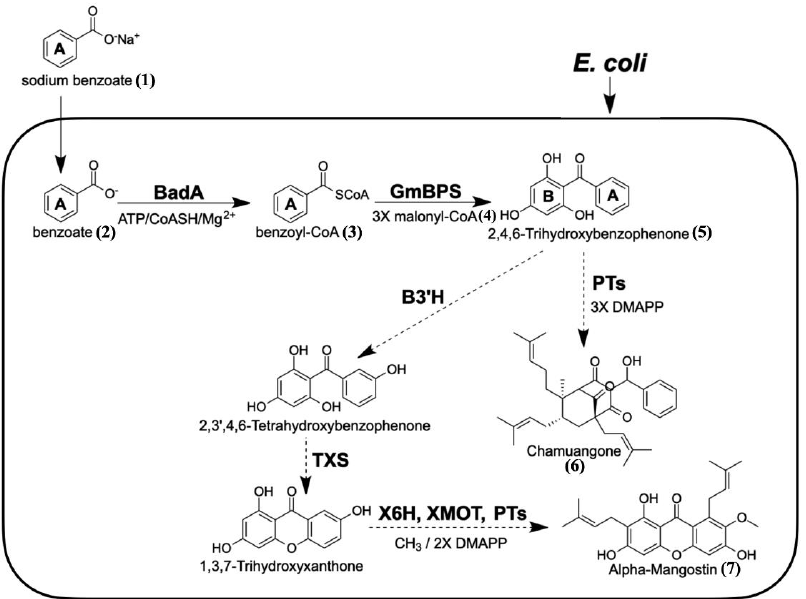
Figure 1. Proposed biosynthetic pathway of 2,4,6-TriHB ( 5 ) in E. coli via the coexpression of BadA and GmBPS (heavy lines). Sodium benzoate ( 1 ) was used as the fed precursor. The synthetic routes that might be extended from 2,4,6-TriHB ( 5 ) towards alpha-mangostin ( 7 ) and chamuangone ( 6 ) are shown (dotted lines). (BadA: benzoate-CoA ligase; GmBPS: G. mangostana benzophenone synthase; PTs: prenyltransferase; B3H: benzophenone 3-hydroxylase; TXS: trihydroxyxanthone synthase; X6H: xanthone 6-hydroxylase; XOMT: xanthone-O-methyltransferase; DMAPP: dimethylallyl diphosphate ).